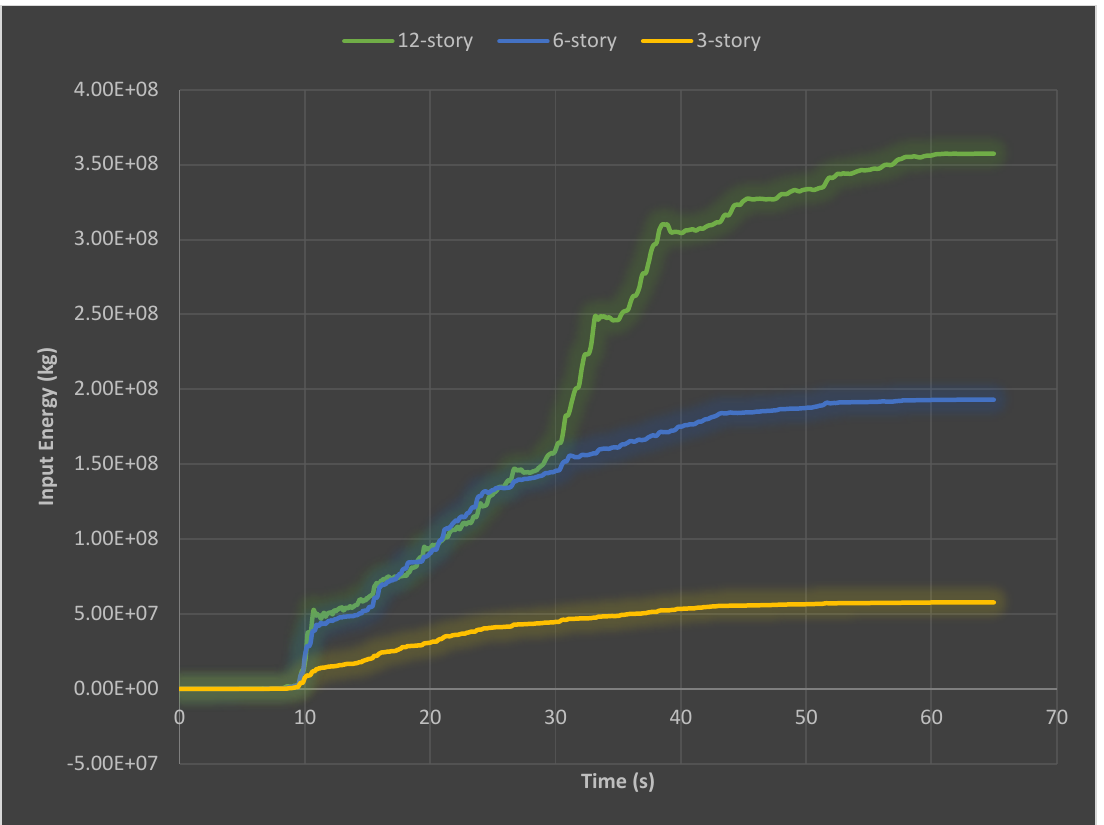
Fig. 12. The highest input energies to the 3, 6 and 12-story structures are due to the Northridge earthquake